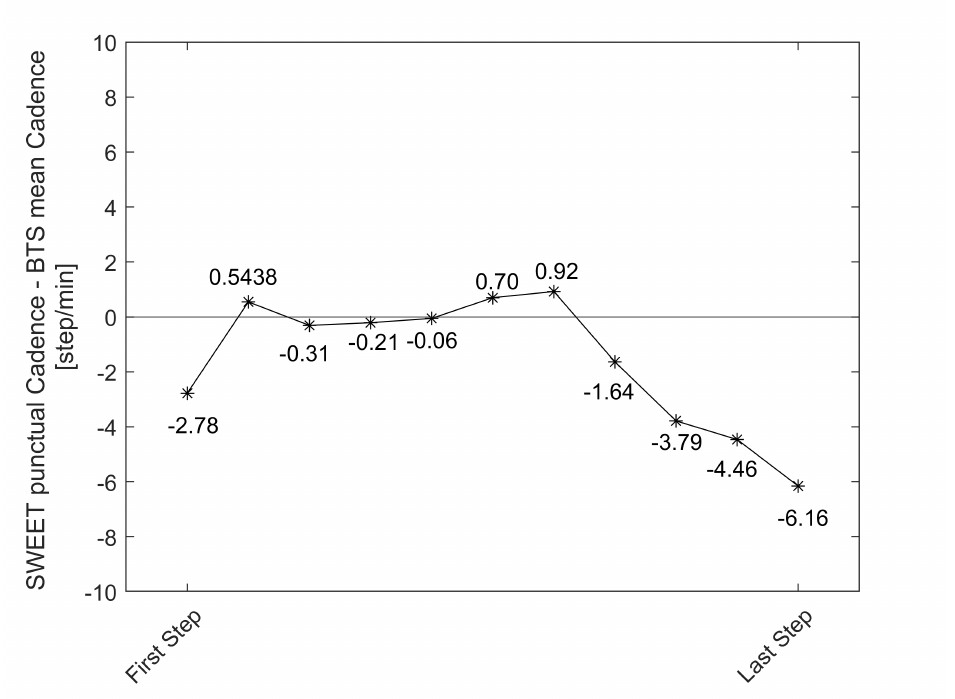
Figure 11. Mean difference between the punctual cadence assessed by SWEET and the mean step cadence suggested by BTS system for each step of the walking